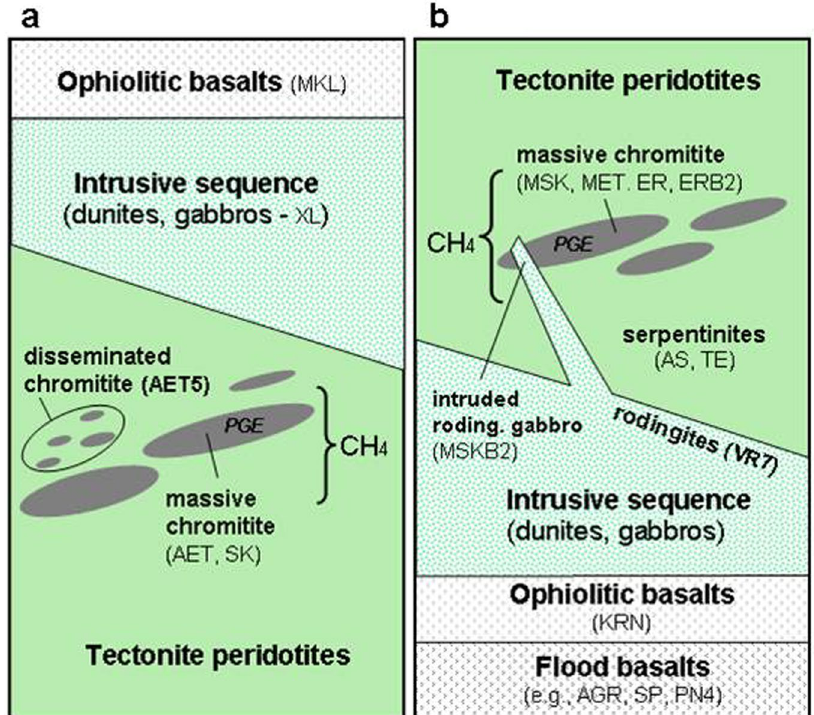
Figure 6. Methane occurrence within the Vourinos ( a ) and Othrys ( b ) ophiolite rocks. Methane occurs only within chromitite-rich layers (massive and disseminated chromitites, with Platinum Group Elements - PGE) within the ultramafic body. Sample acronyms are described in Supplementary Table 1 (see also Fig. 2). Peridotites and other rocks overlying or underlying the chromitites, i.e. gabbros and basalts (above the chromitites in the Vourinos ophiolite; below the chromitite in the inverted Othrys ophiolite) are devoid of methane. Also all flood basalts that separate the Othrys ophiolite from the basement (Pelagonian Unit) are